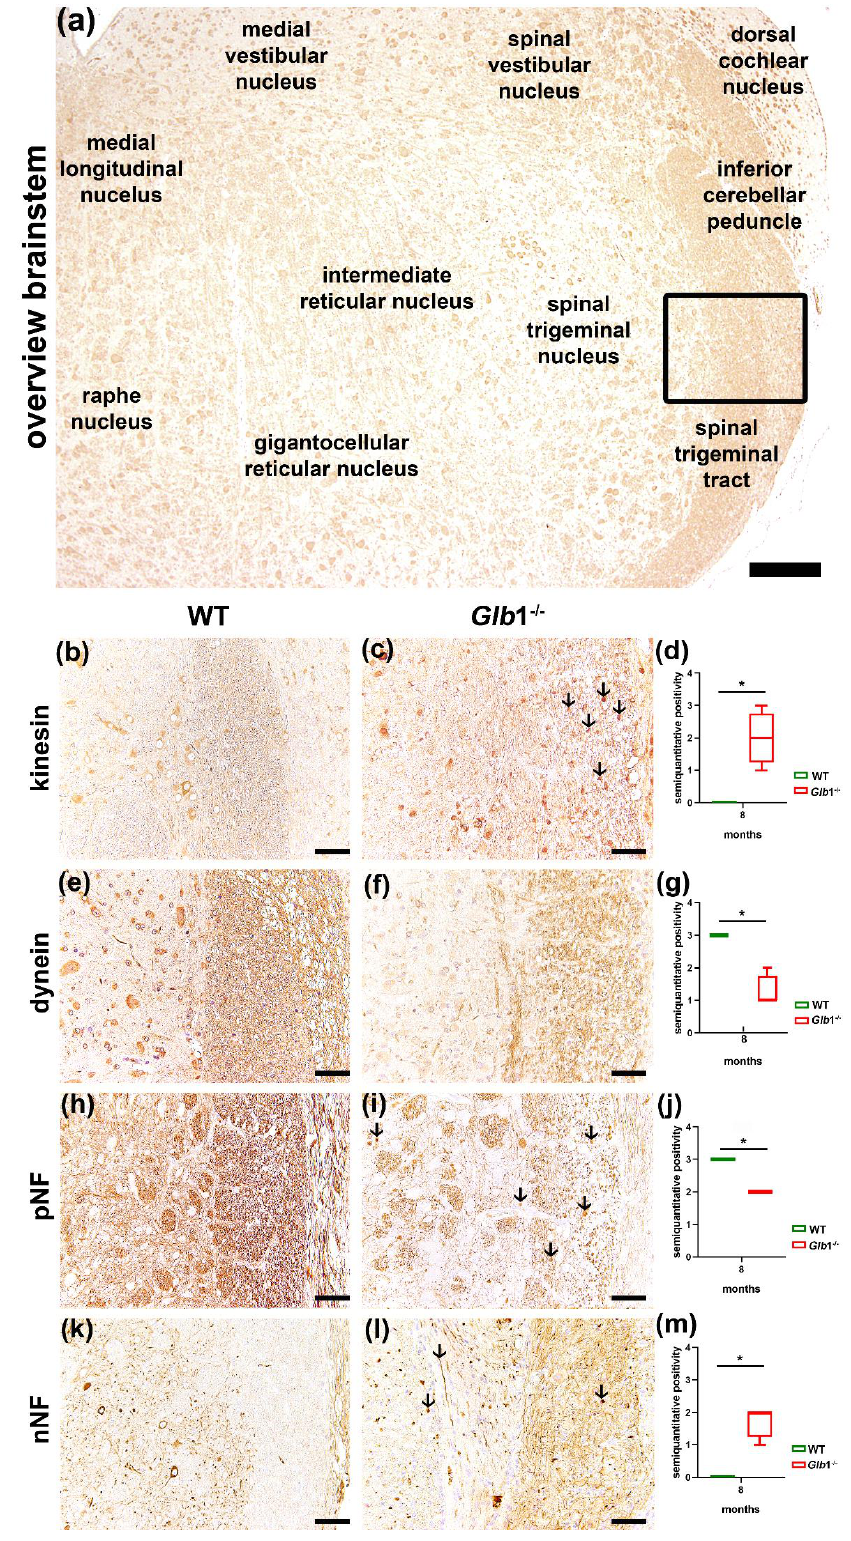
Figure 4. Immunohistochemistry of the brainstem with axonal damage. ( a ) Overview of the brainstem (eight-month-old wildtype (WT), kinesin). ( b – m ): Brainstem of an eight-month-old Glb1 − / − mouse compared to an eight-month-old WT. ( b – d ) Kinesin protein in brainstem axons; ( b ) eight-month-old